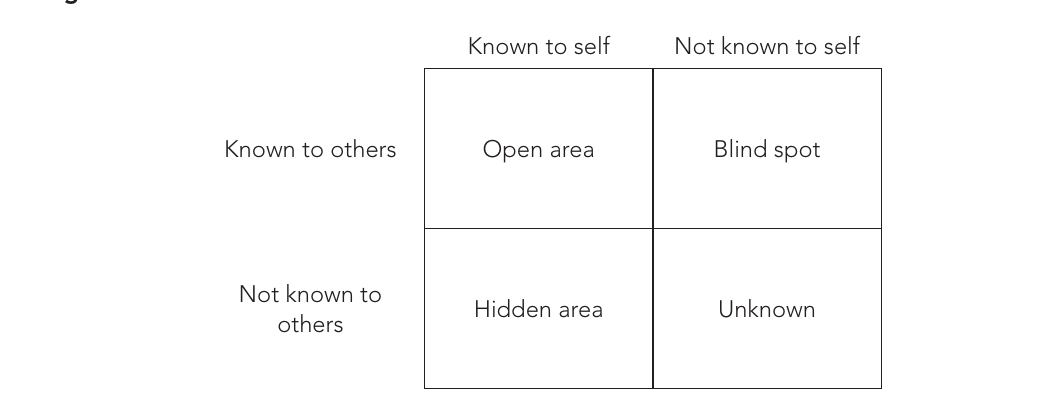
Figure 1: Johari window